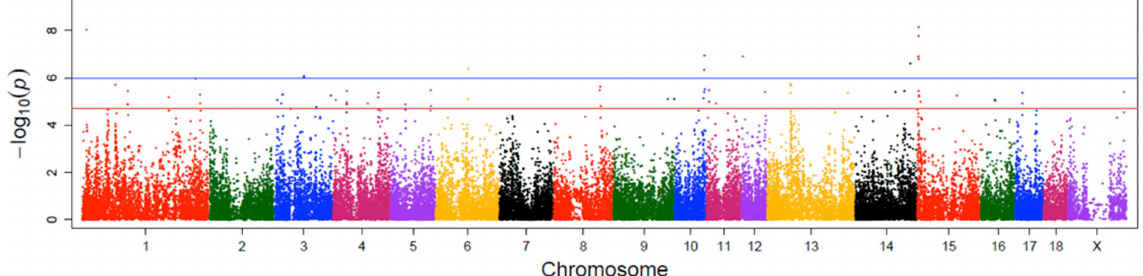
Fig 2. Manhattan plot of the genome-wide association analysis of EBV D110. The red and blue lines indicatethe suggestive (-log10[p-value] (cid:21) 4.7) and the Bonferroni-adjusted genome-wide significancethreshold (-log10[p-value] (cid:21) 6), respectively.